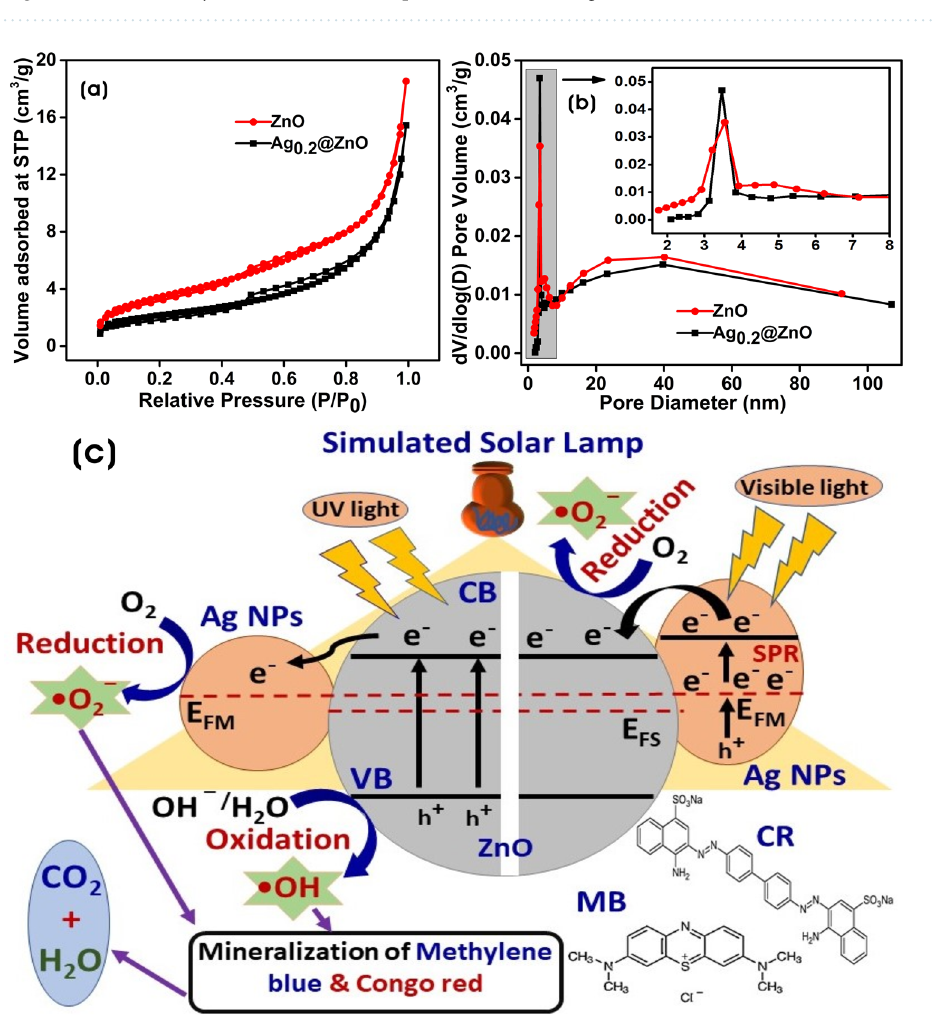
Figure 10. The N 2 adsorption–desorption isotherm of ZnO and Ag 0.2 @ZnO NC. ( a ) BET surface area analysis ( S BET ), and ( b ) pore size distribution and ( c ) schematic diagram illustrating the photocatalytic degradation of MB and CR dyes by Ag@ZnO